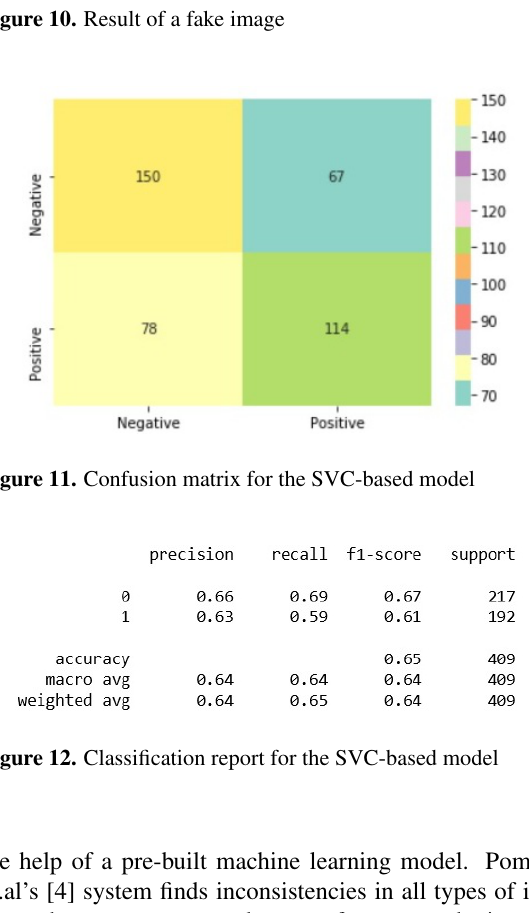
Figure 6. Training of CNN model Figure 7. Graphical user interface of the proposed system